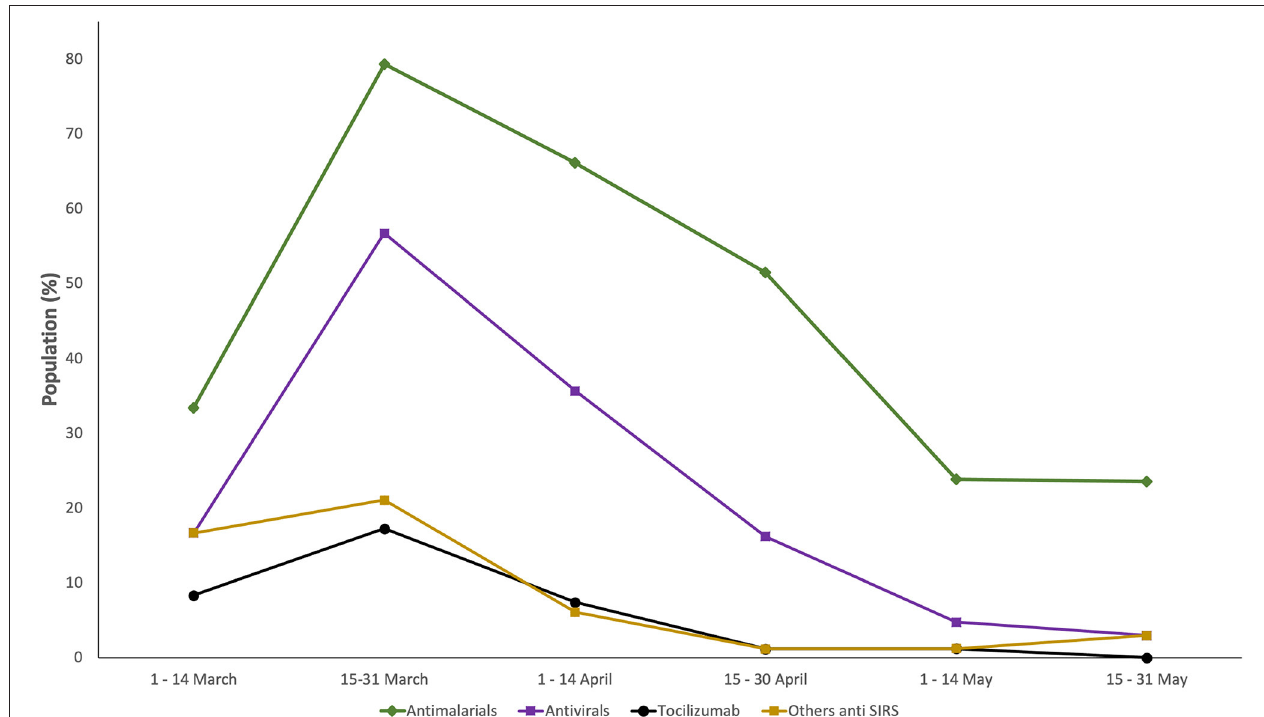
FIGURE 2 | Trends in the use of the medications used by in-hospital COVID-19 patients with acute kidney injury (AKI) in Castile and Leon (Spain) (March 1st–May 31th, 2020).